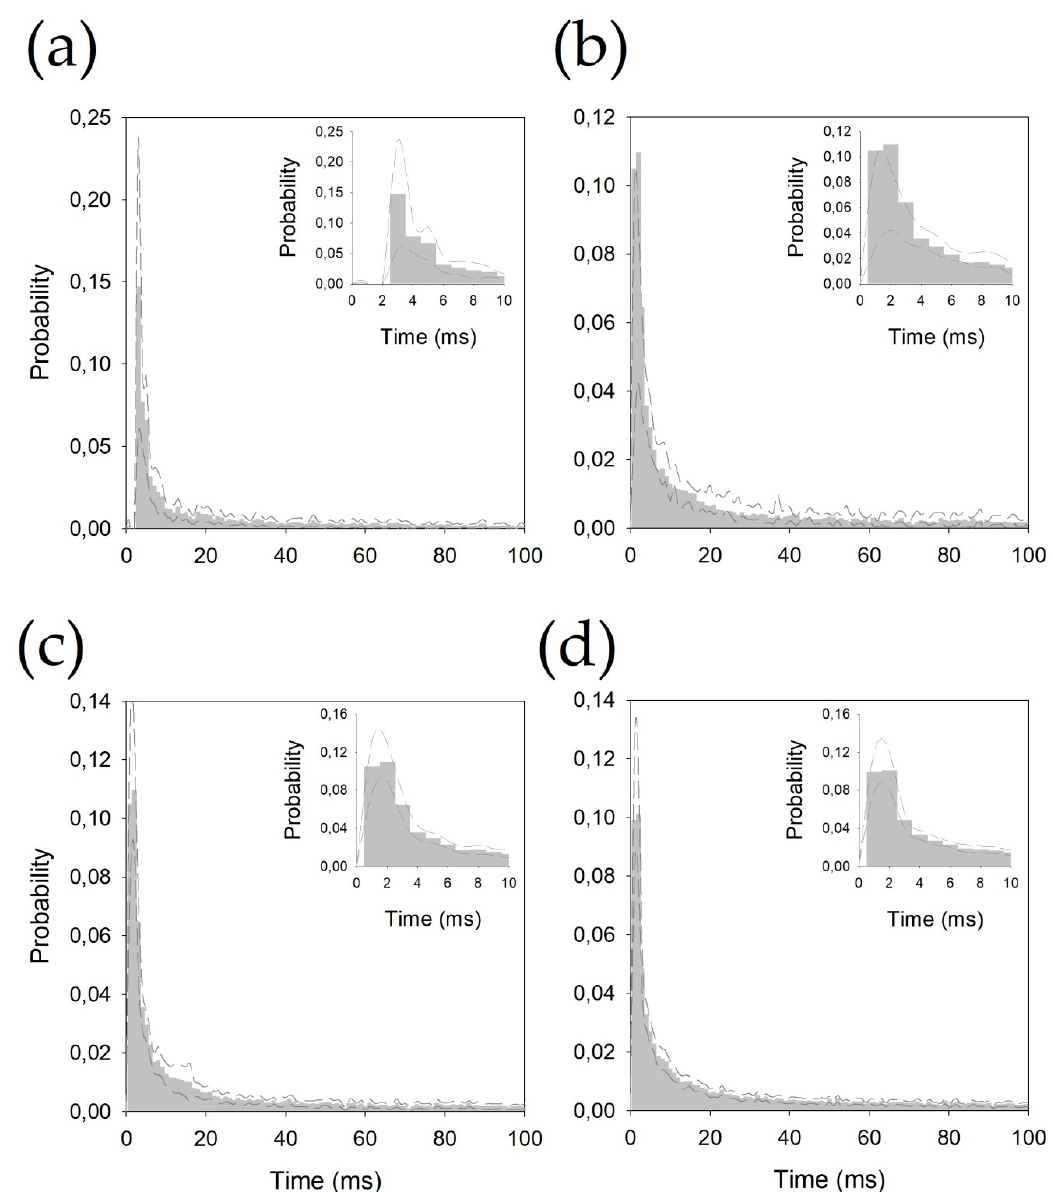
Figure 2. Probability density functions pooled for ( a ) centromedian magnocellular (Ce.mc), ( b ) centromedian parvocellular (Ce.pc) ( c ) ventral intermediate thalamic nucleus (V.im), and ( d ) ventral caudal thalamic nucleus (V.c). Discontinuous lines represent ± 2.5 SEM. Insets show the details of the first 10 ms.